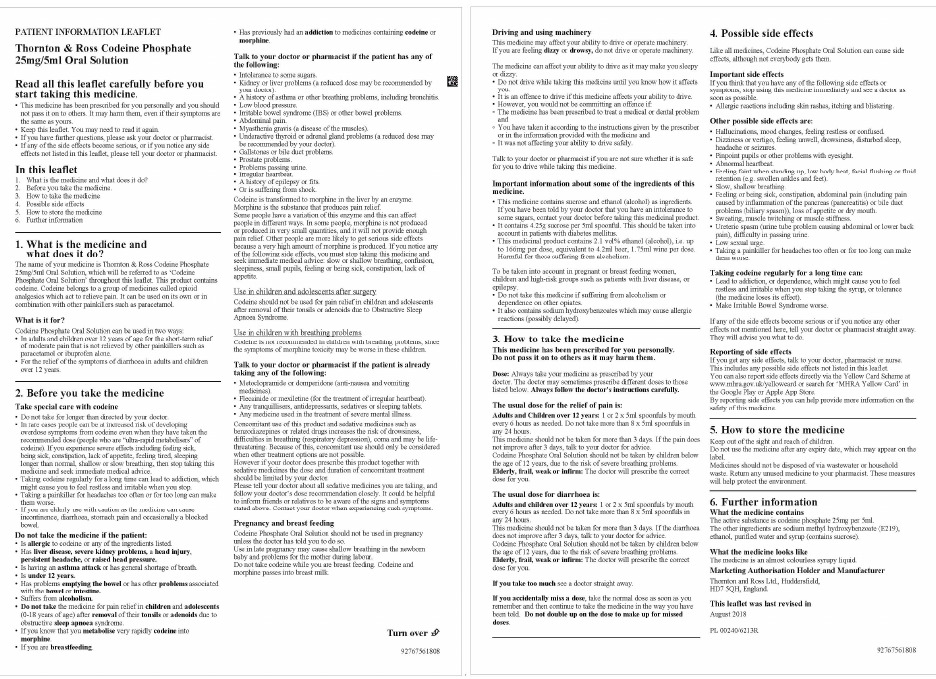
Figure 2. Sample 2 [49].